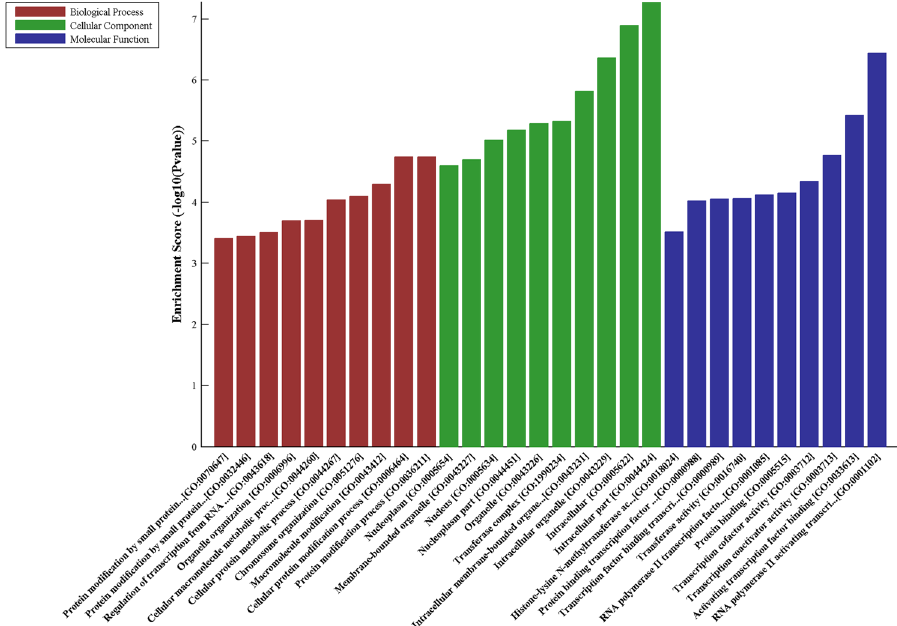
Figure 5. GO enrichment for circRNA-targeted mRNAs upregulated in samples from the DM1 group.